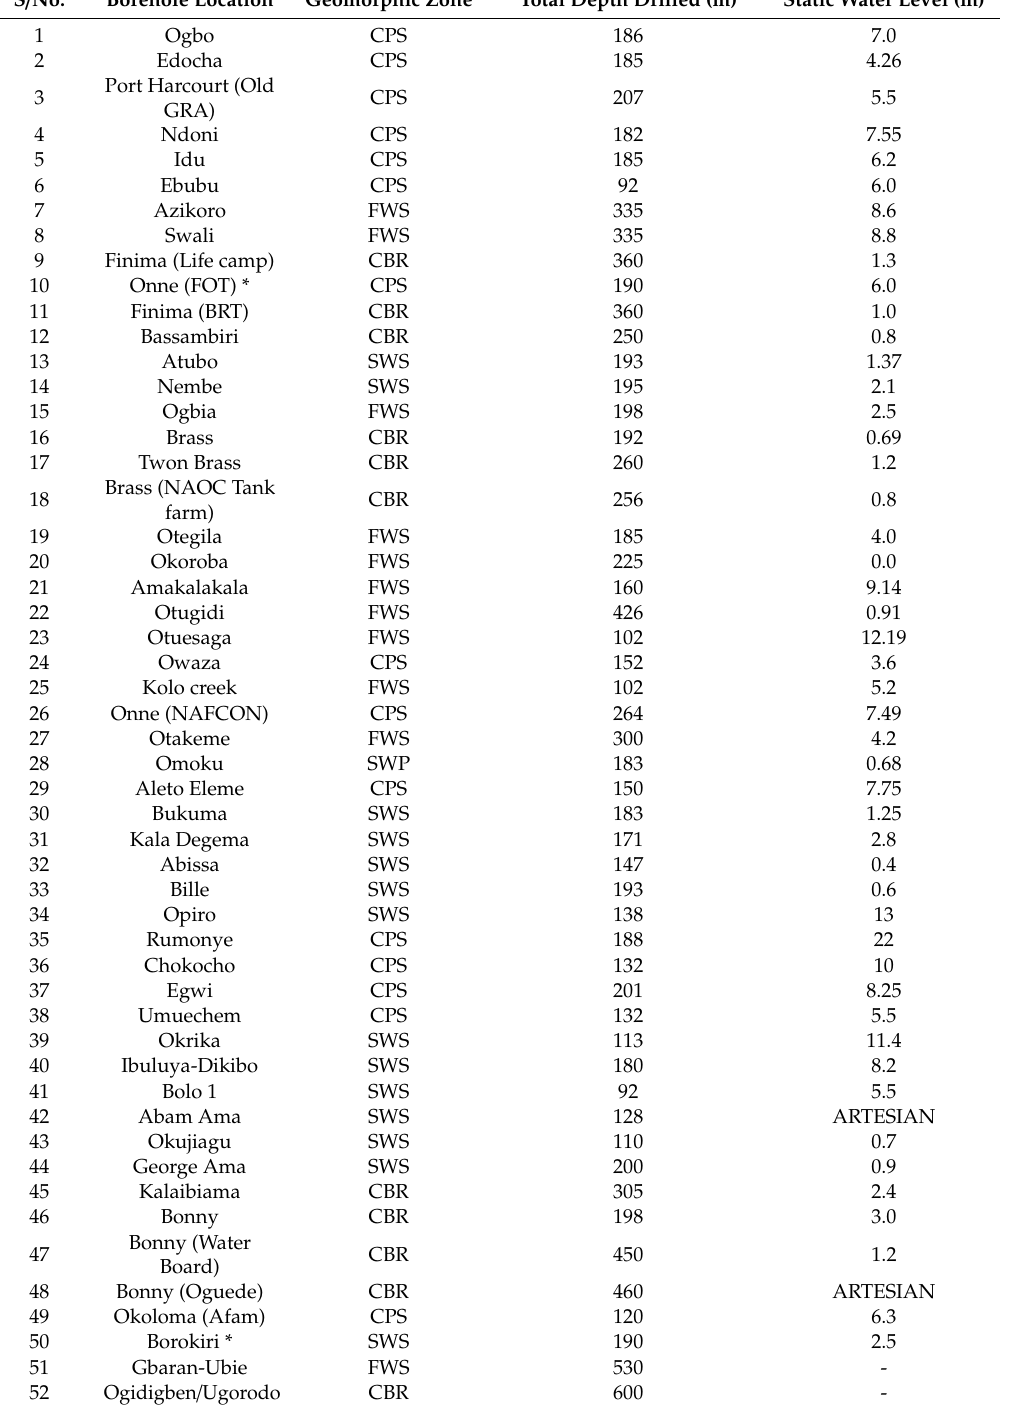
Table 2. Borehole locations with strata logs, their depths and static water